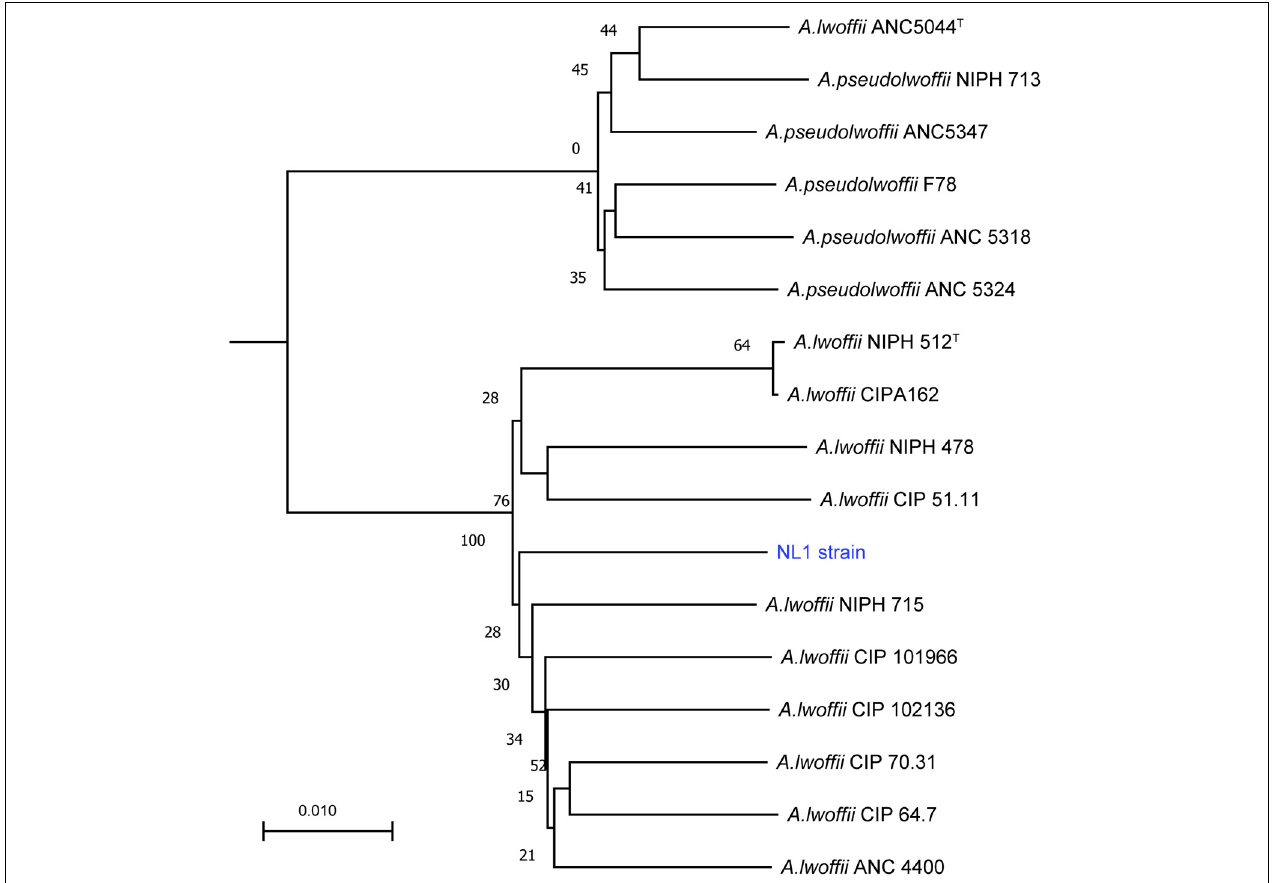
FIGURE 2 | Whole-genome sequence-based phylogenetic tree of A. lwoffii and A. pseudolwoffii strains.